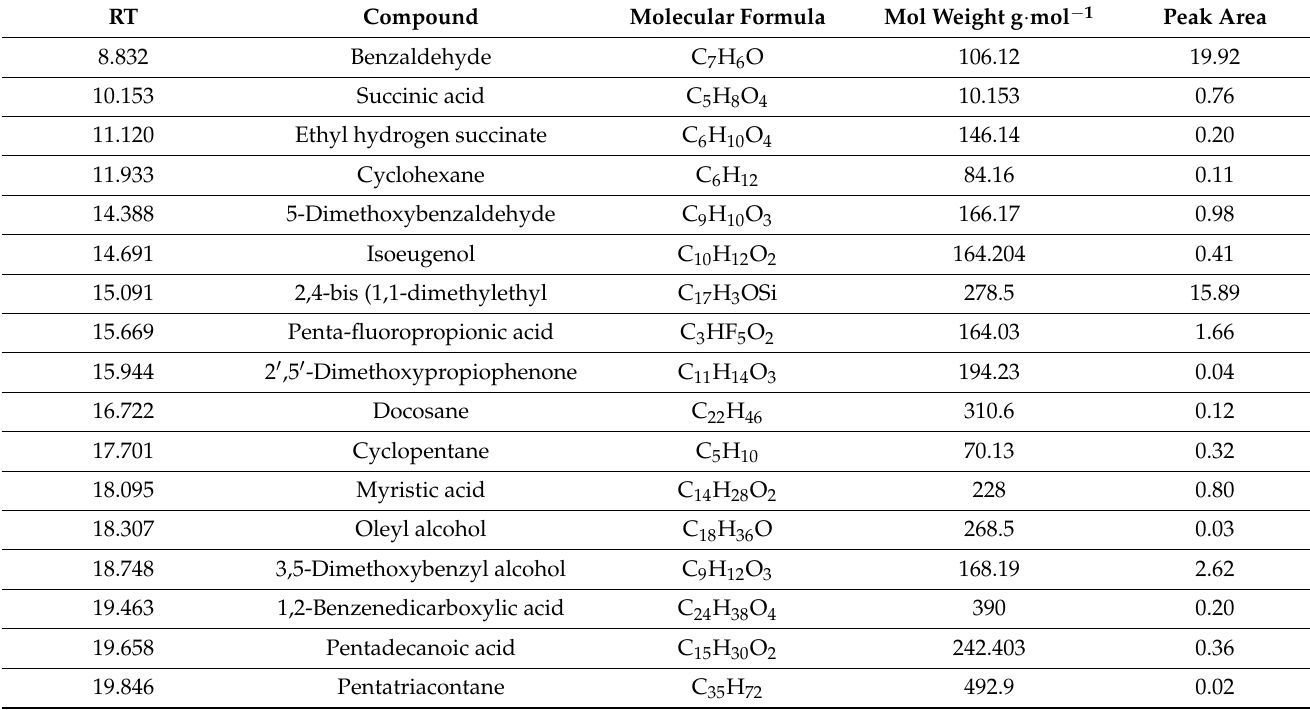
Table 1. Phytocompounds identified in MPME by GC-MS